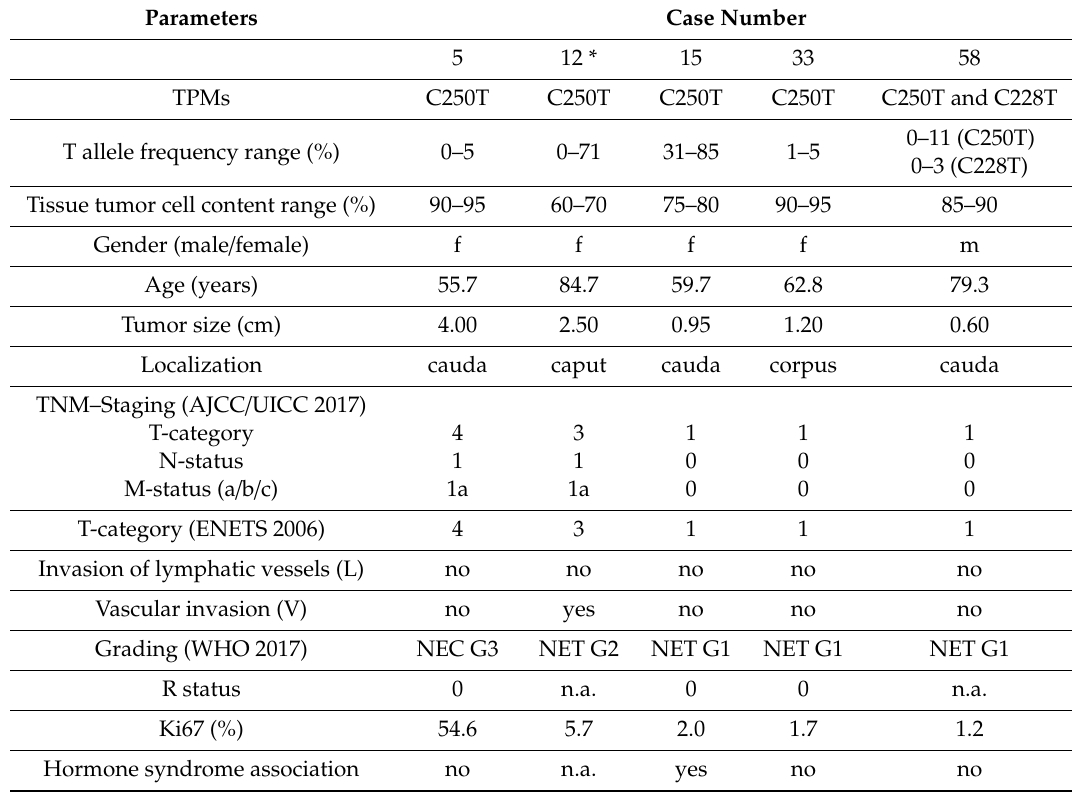
Table 2. Detailed clinicopathological data of pNEN patients with